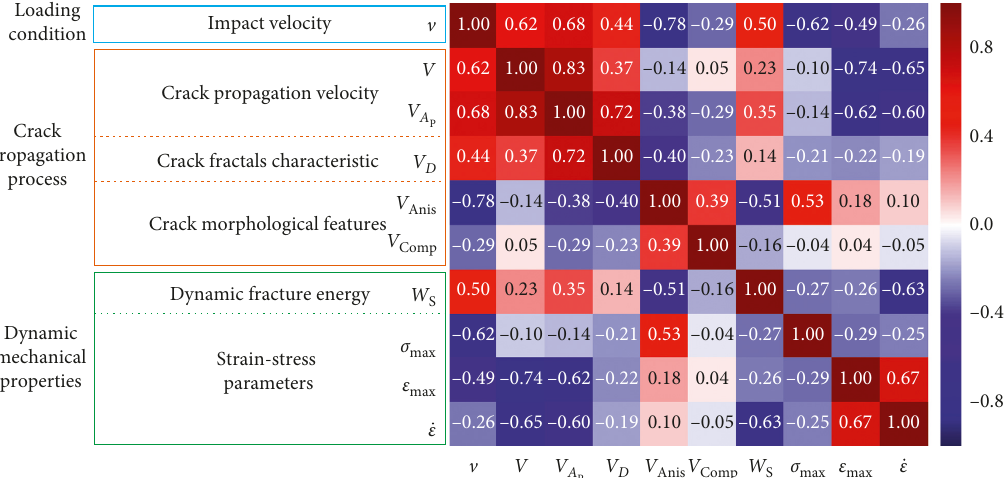
Figure 4: An illustration of the correlation matrix heat-map with loading condition, crack propagation process, and dynamic mechanical fractal dimension of the crack can be accumulated by Figure 8 presents an illustration for crack coverage formula (8). using different scale boxes ( S 8 , 16 , 32 , 64), while (cid:28) In general, the higher fractal dimension indicates a more Figure 9(a) plots the linear fitting results of ln N and ln S , curved and intricate crack propagation path. Therefore, which shows the fractal dimension is 1.14 for current cracks according to the above method, the fractal dimension of on rock surface. Based on the plots of ln N and ln S , the